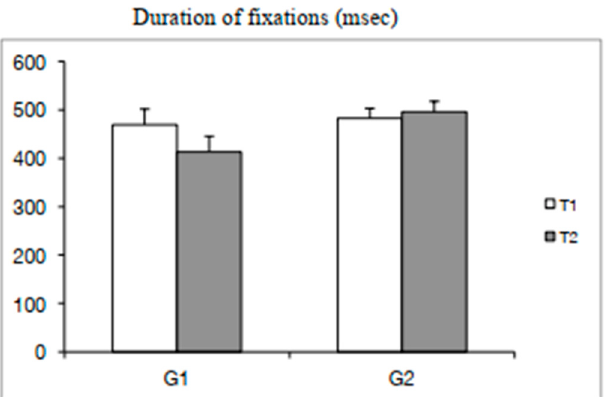
Figure 3. Means and standard deviations of the duration of fixations (ms) at T1 and T2 for both groups